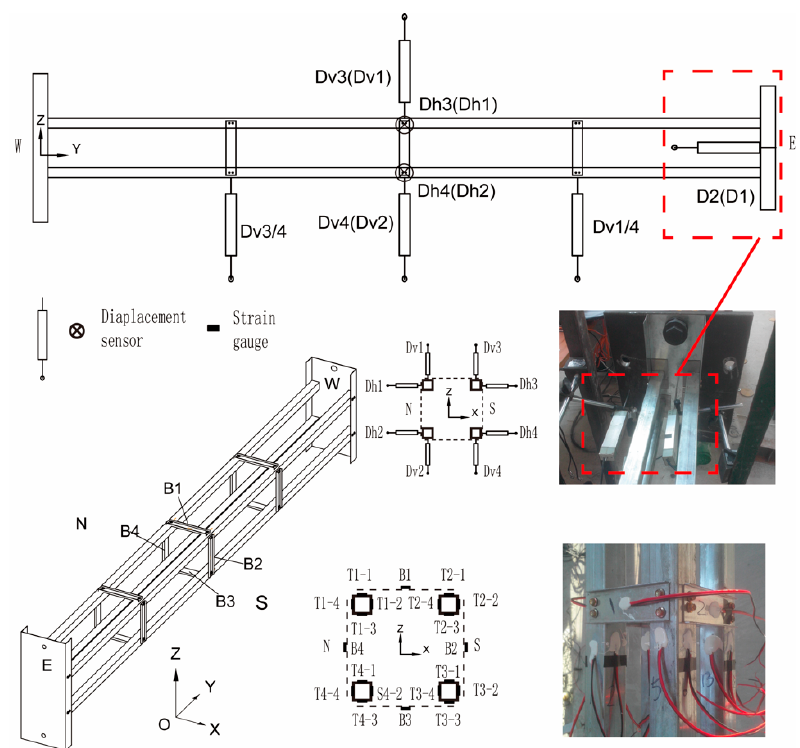
Figure 3. Measuring devices.